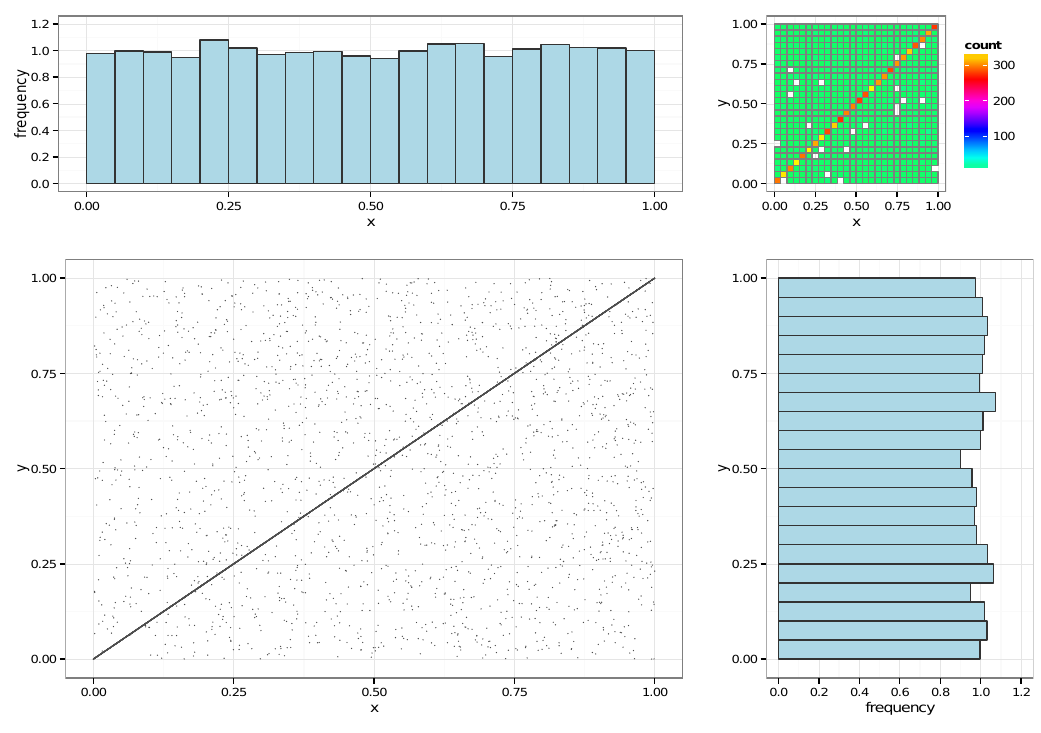
Figure 1: Sample of size 10.000 from ( X , Y ) ∼ T λ ( M ) for λ = 1/2 , its two dimensional histogram and the corresponding marginal